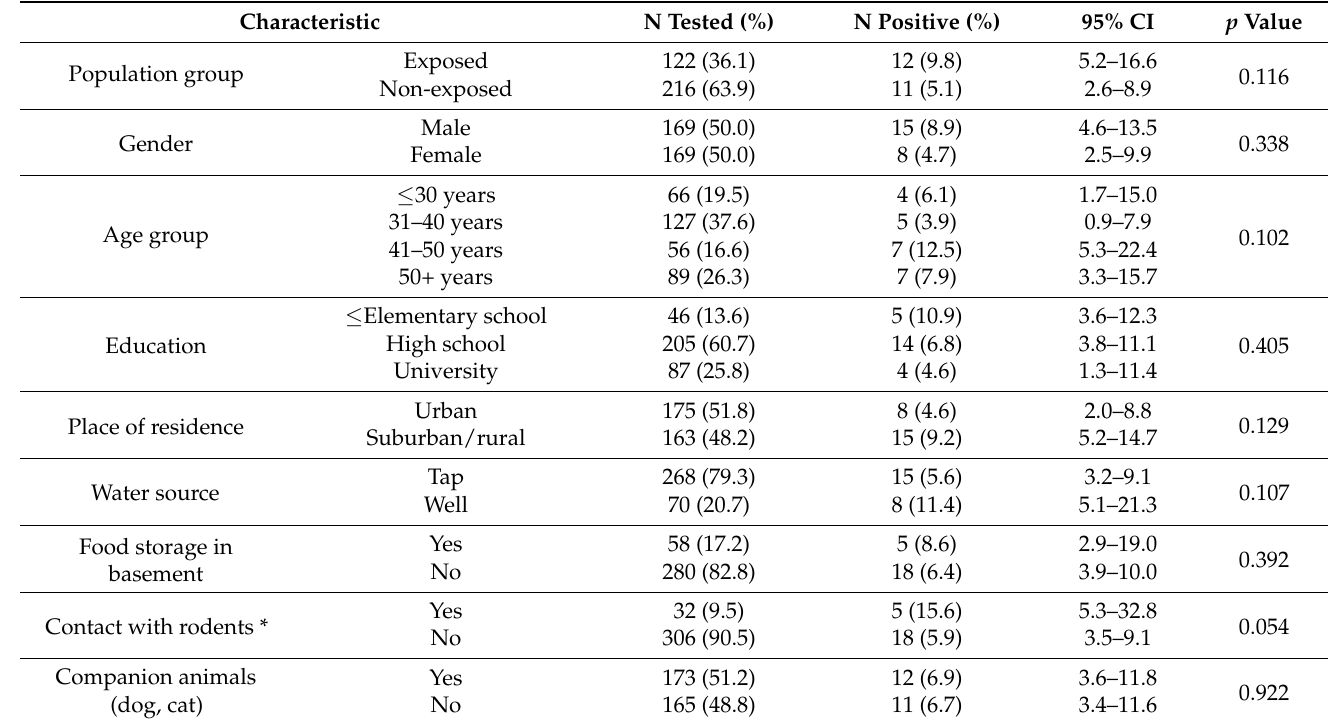
Table 2. Prevalence of LCMV antibodies according to sociodemographic characteristics and risk factors. Characteristic